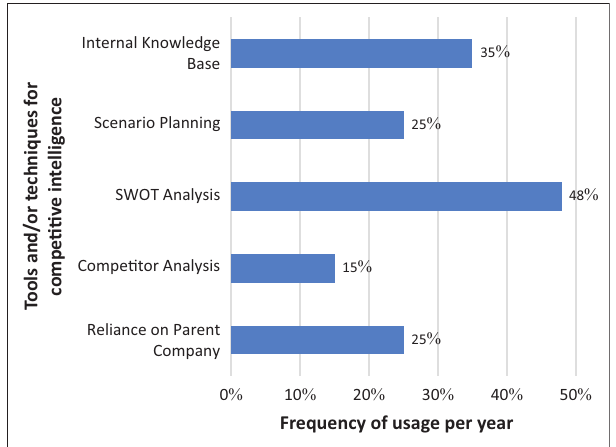
FIGURE 1: Strategic tools and/or techniques used in generating competitive